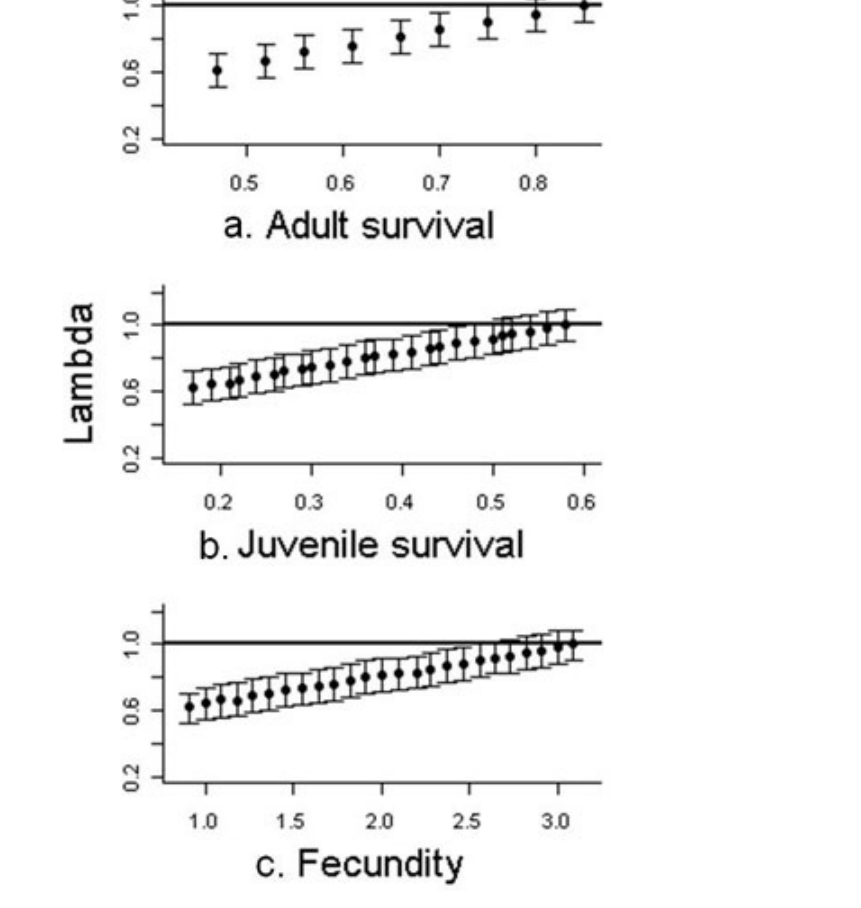
Fig. 3 . Predicted values of l for Streaked Horned Larks in western Washington, USA, with successive increases in each vital rate. Each point represents a 10% increase in the vital rate. Only one vital rate was manipulated at a time. Error bars represent ±1 SD. The solid horizontal line represents l =